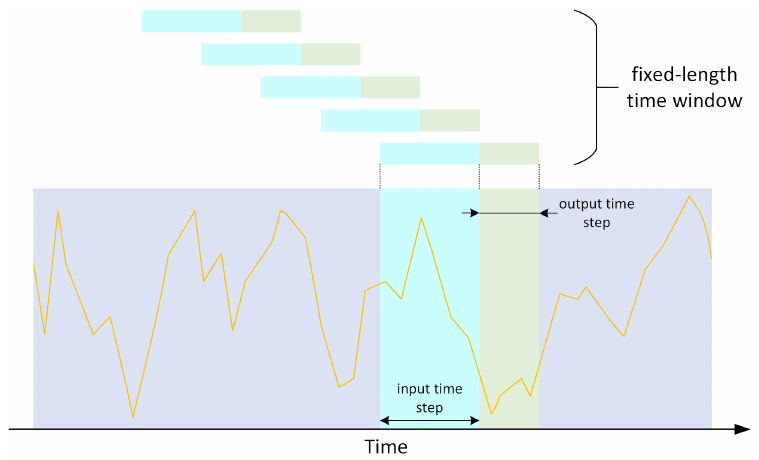
Figure 7. Using sliding time window to convert time sequence data into supervised learning data.